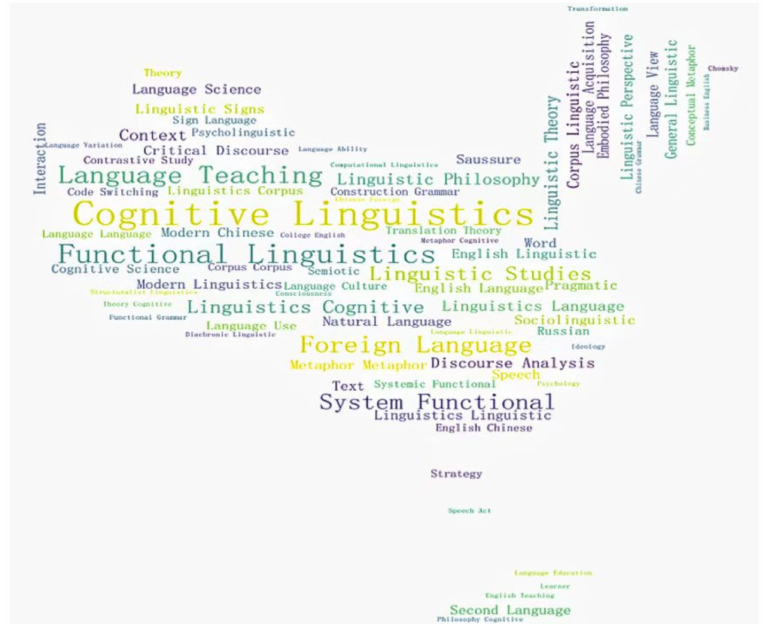
Figure 11. Word cloud map of hotspots in the linguistics